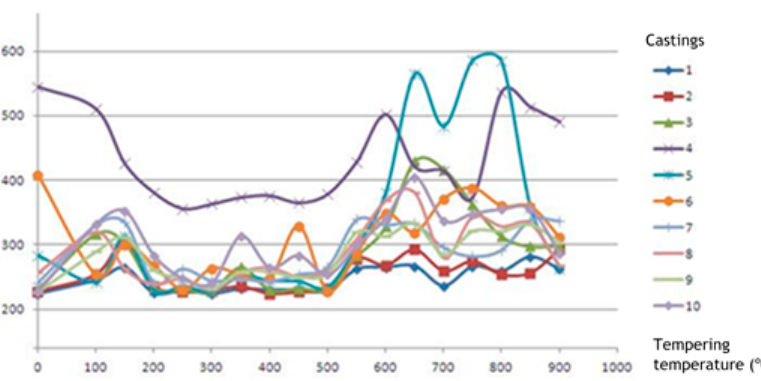
Figure 2. Hardness versus tempering temperature. The zero value for the x ‐ axis corresponds to the sample which was hyperquenched in air and did not undergo subsequent tempering.